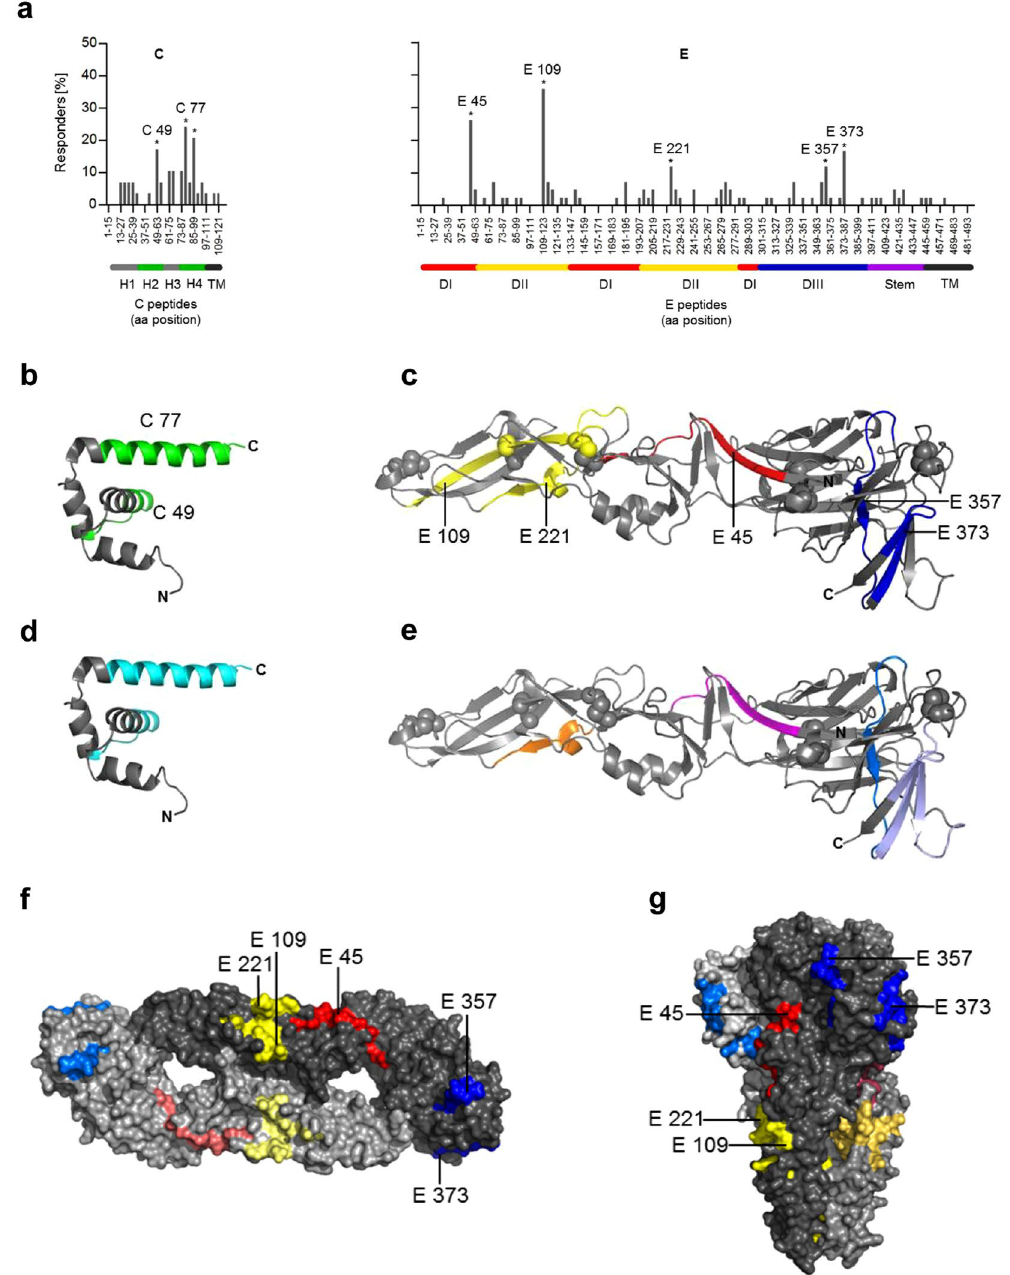
Figure 3. Mapping of immunodominant CD4 T cell responses specific for YF virus C and E proteins. ( a ) Percentage of positively tested YF-vaccinated persons recognizing a specific peptide within C (n = 29) and E (n = 42). Amino acid positions of peptides within the protein sequence are indicated on the x-axis. Peptides recognized significantly more often than the average are indicated by asterisks and are denoted by the first amino acid of the 15mer peptide used for single peptide testing (Fisher´s exact or chi-square test; p < 0.05). ( b,d ) Ribbon diagram of the crystal structure of the flavivirus Kunjin (KUN) C protein (PDB 1SFK) 40 , consisting of four helices (H1 to H4); for the amino-terminal region (grey line), no crystallographic data exist. ( c,e ) Ribbon diagram of the crystal structure of the TBE virus sE (PDB 1SVB) 16 consisting of three domains (DI-III). ( b,c ) The dominant YF virus epitopes are colored as follows: C-green; E: domain I-red; domain II- yellow; domain III-blue. Spheres represent disulfide bridges. ( d,e ) Immunodominant epitopes derived from YF-17D and TBE cohorts identified at congruent positions are colored as follows: C protein (cyan); E protein DI (magenta), DII (orange) and DIII (blue); ( f,g ) surface representations of the neutral pH, dimeric form of sE in a top view and the postfusion trimeric form in a side view (PDB 1URZ) 22 . The immunodominant peptides are colored in each monomer according to corresponding domains: DI (red), DII (yellow) and DIII